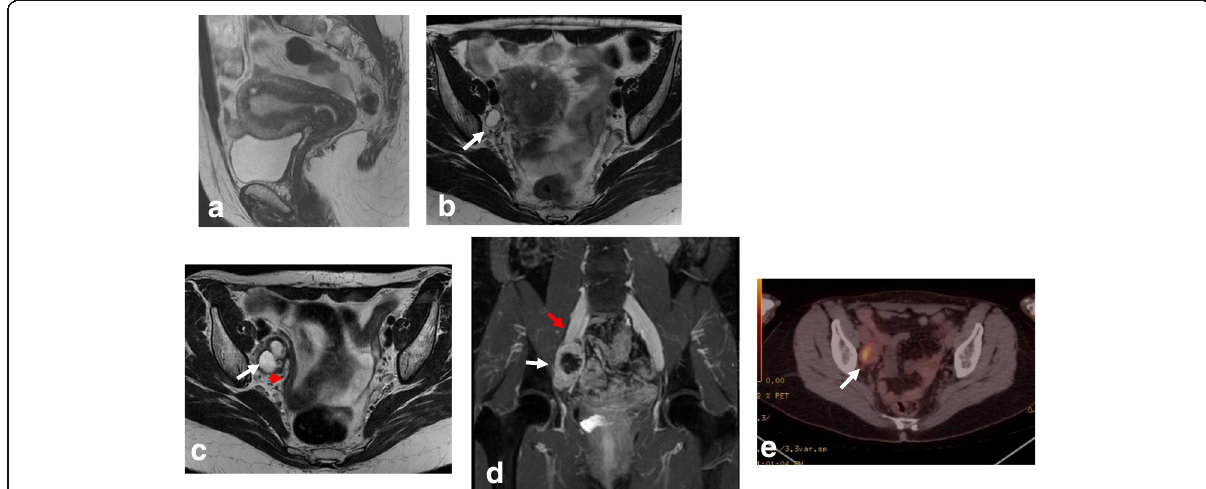
Fig. 25 a , b MRI of a 48-year-old woman with known adenomyosis, a previous cesarean section, and FIGO IA1 cervical cancer diagnosed in an outpatient clinic, including sagittal T2WI ( a ) and axial oblique T2WI ( b ). No anomalies are visible in the cervix. The cystic image in the right obturator space (arrow in b ) was interpreted as a right ovary with a small follicle. The patient underwent simple extrafascial hysterectomy with ovarian removal. Post-surgical histology confirmed FIGO stage IA1 (high-grade squamous cell carcinoma), without LVSI and with a clear surgical margin. c , d MRI was performed 6 months after surgery, including axial oblique T2WI ( c ) and coronal MIP-DCE sequence imaging ( d ). The right obturator cystic lesion increased in size and in contact with right iliac vessels (arrows). Images also show medial displacement of the right pelvic peritoneal fascia (red arrowhead) indicating an extraperitoneal origin of the cystic lesion. e 18 F-FDG PET-CT shows avid enhancement of the cystic mass. Lymphadenectomy was performed. Histological analysis showed metastatic adenopathy of cervical